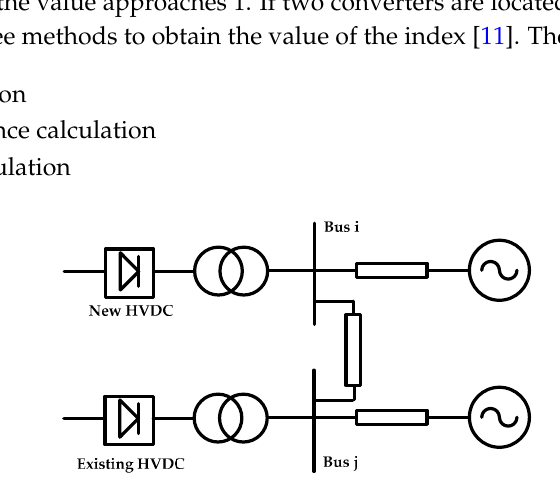
Figure 1. Multi-infeed high-voltage direct current (HVDC) systems.